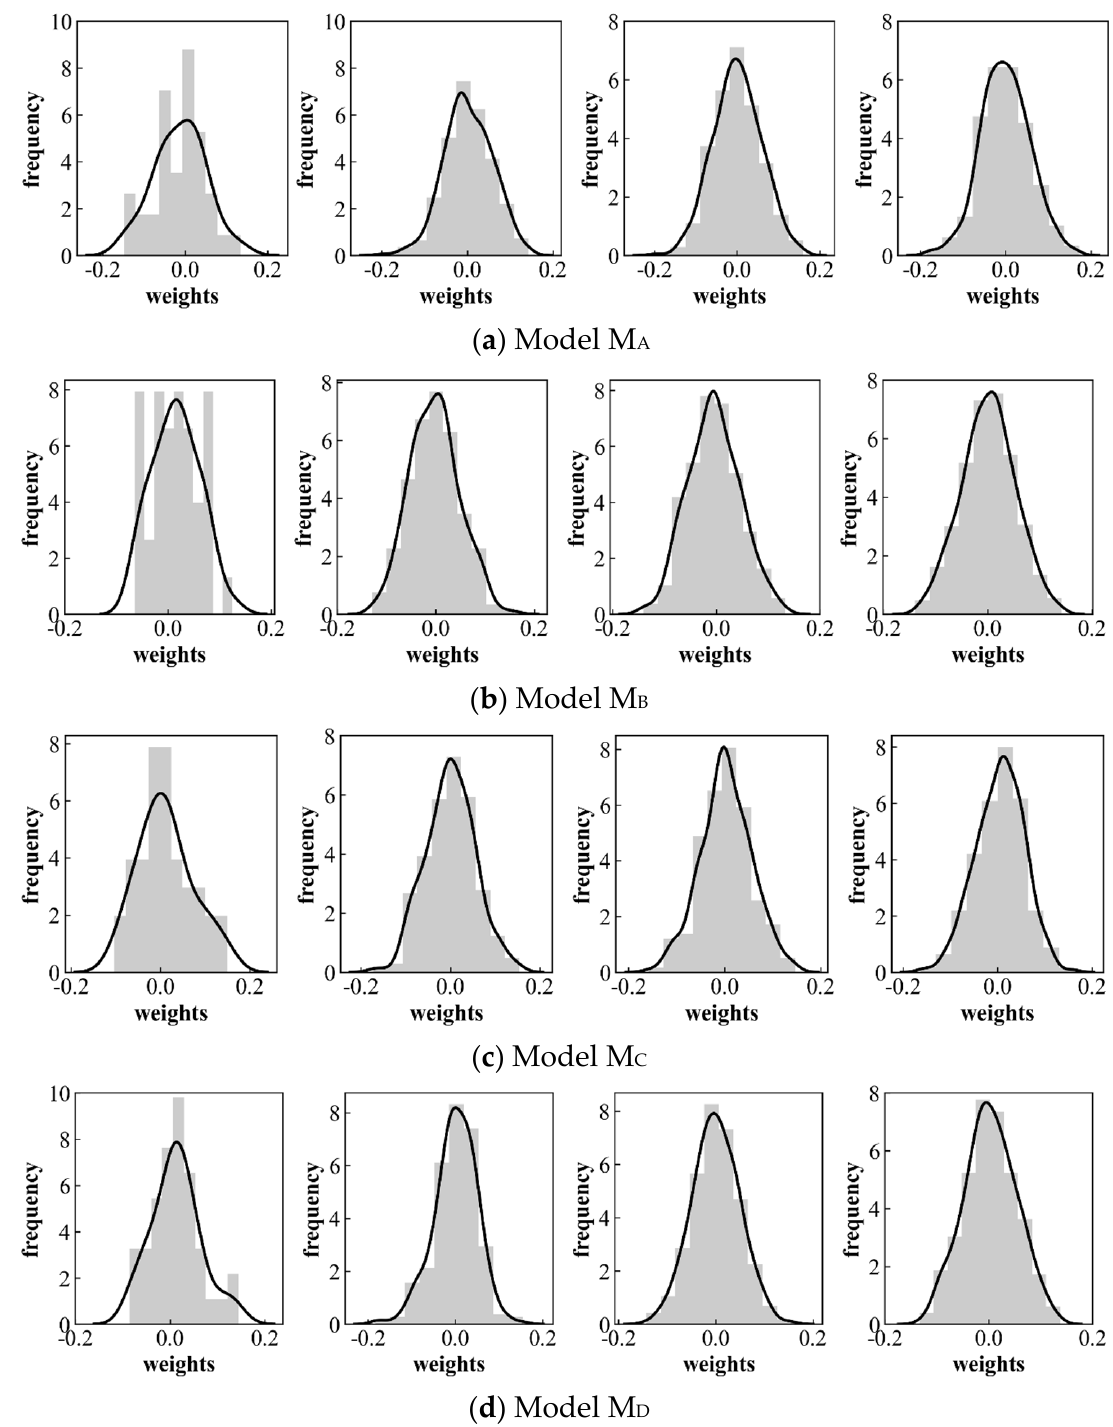
Figure 13. The weight distribution of the local fault diagnosis models.